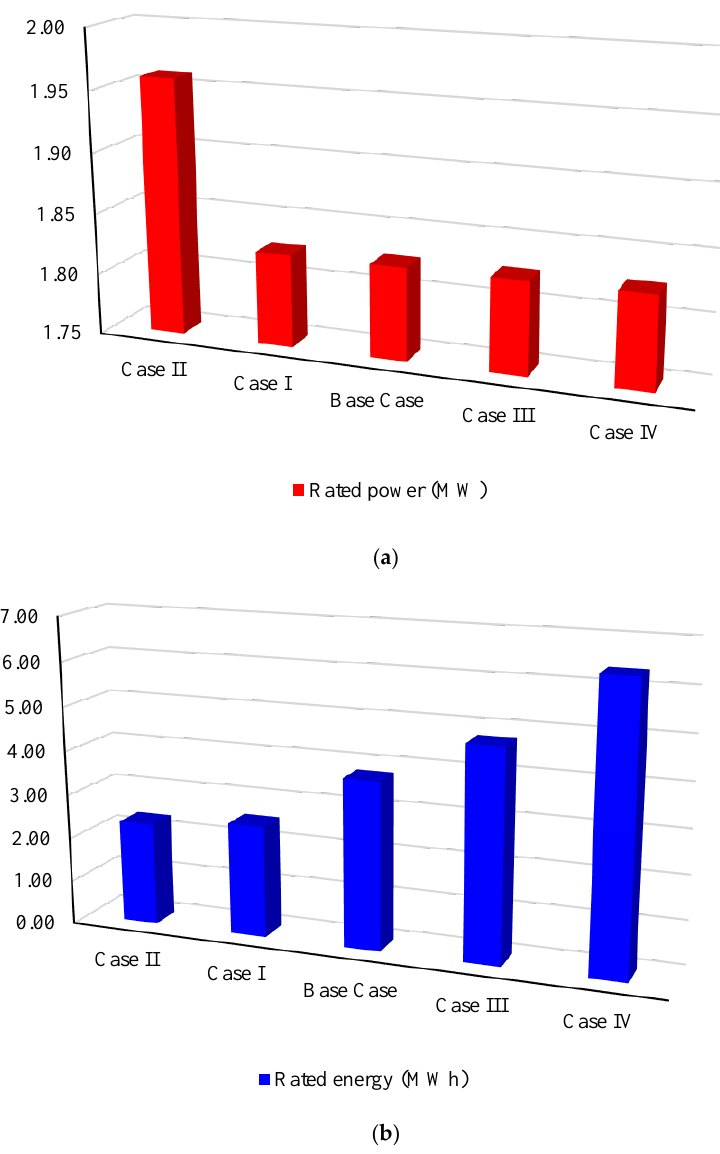
Figure 11. Optimal sizing of the BESS results for the C-rate sensitivity case study ( a ) for power (MW) and ( b ) for rated energy (MWh).